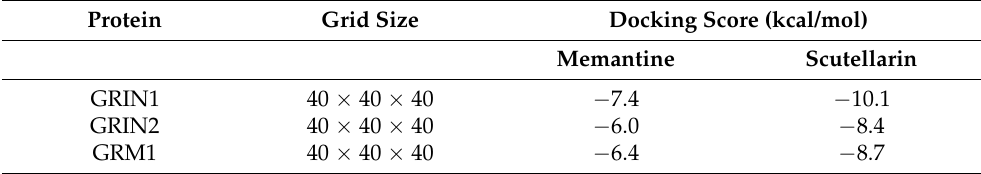
Table 1. The docking score between memantine, scutellarin and glutamate